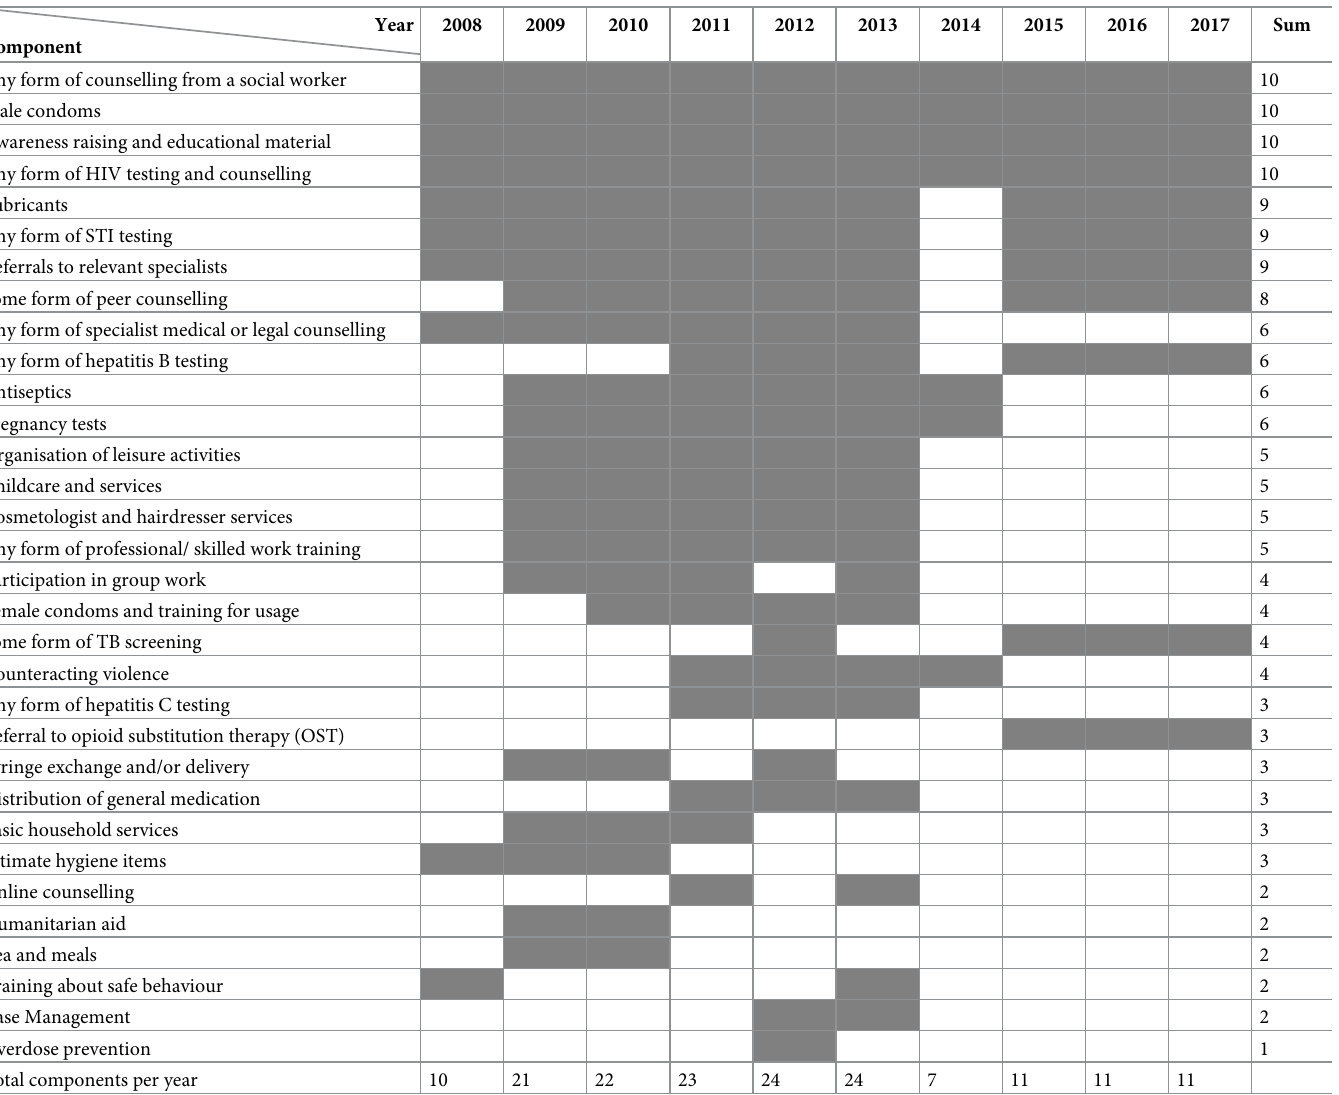
Table 2. Overview of components of the PP provided by Alliance from 2008 to